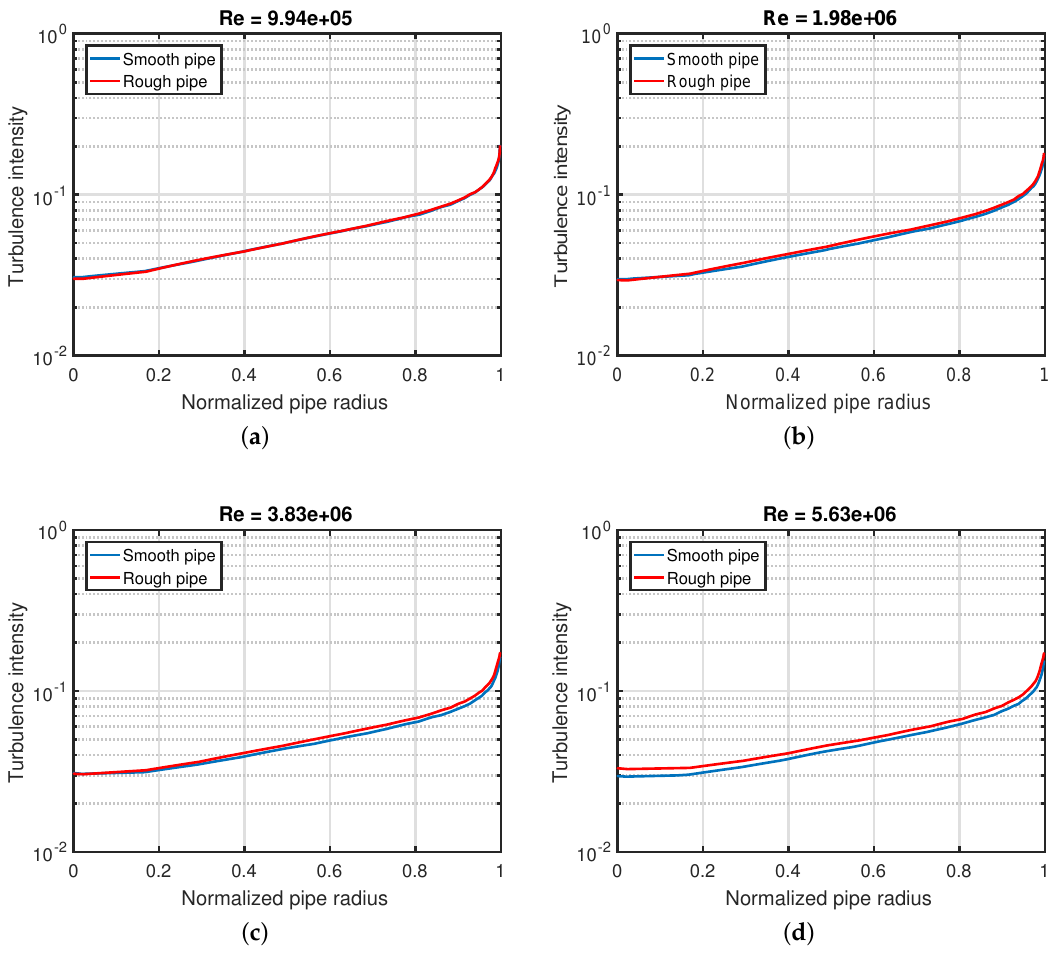
Figure 2. Comparison of smooth and rough pipe turbulence intensity (TI) profiles for the four Re values where the rough pipe measurements are done, ( a ): Re = 9.94e + 05; ( b ): Re = 1.98e + 06; ( c ): Re = 3.83e + 06; ( d ): Re = 5.63e + 06.